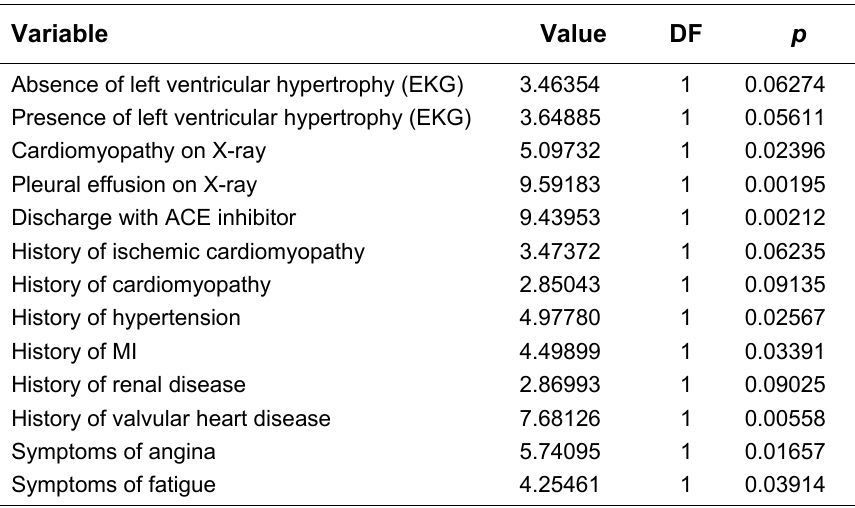
Mortality within 90/365 Days of Discharge — Pearson Chi-Square 365